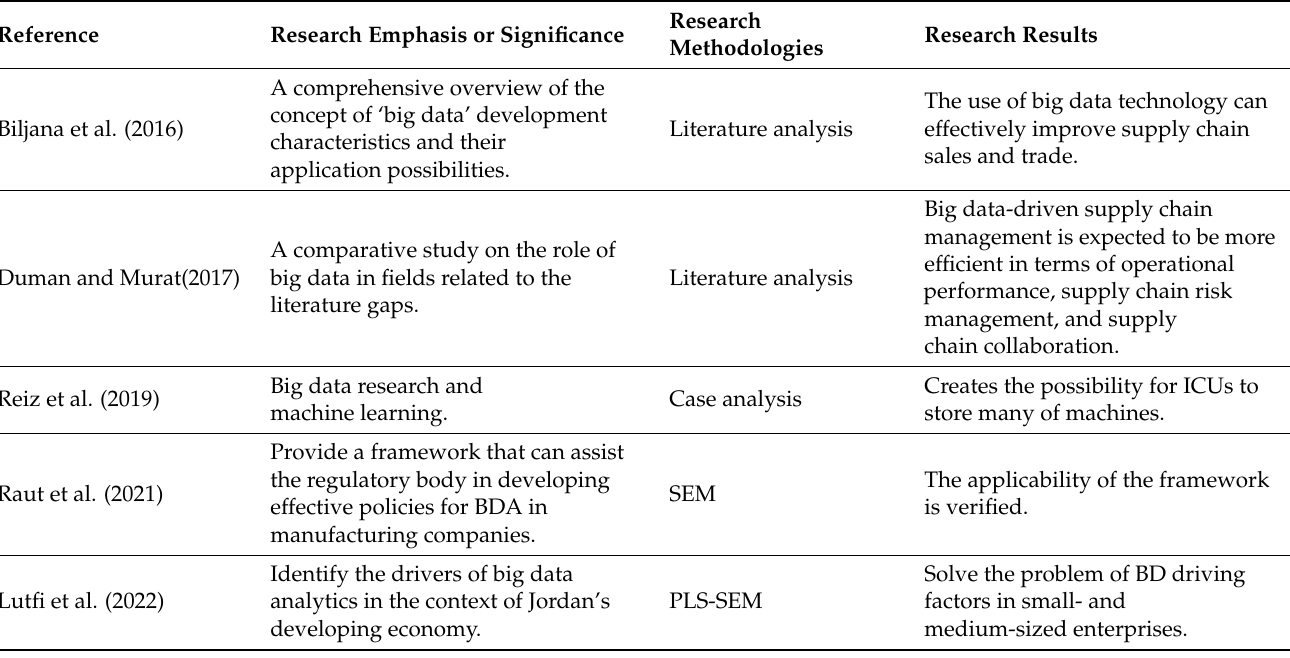
Table 3. Summary table of big data supply chain